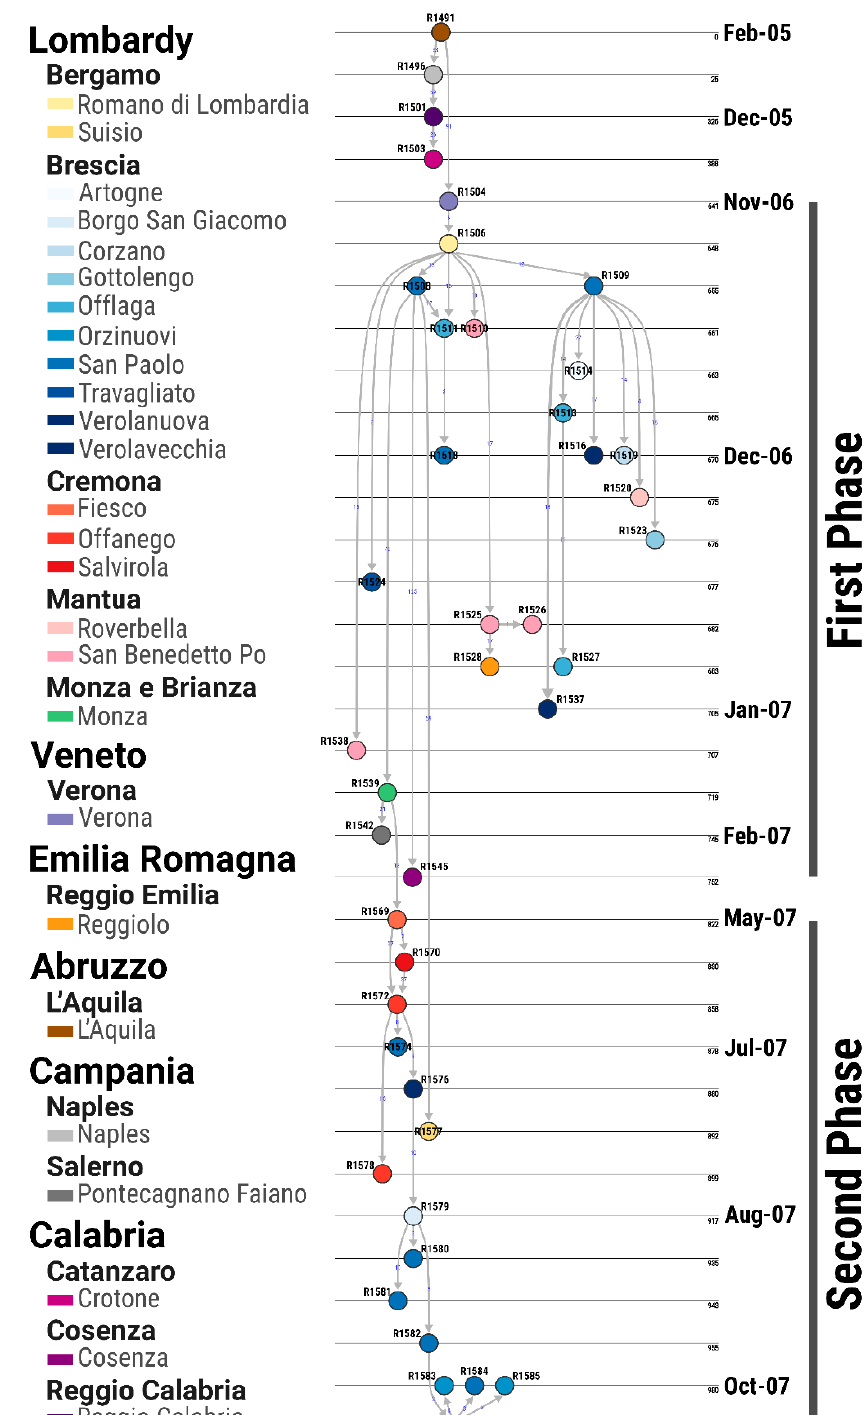
Figure 4. Transmission tree of the 2006–2007 SVD epidemic in northern Italy mapped in time. Nodes are coloured according to the municipality of the farm location. Blue numbers reported close to the arrows represent nt changes estimated between the SVDV genome sequences isolated from each of the linked farms.